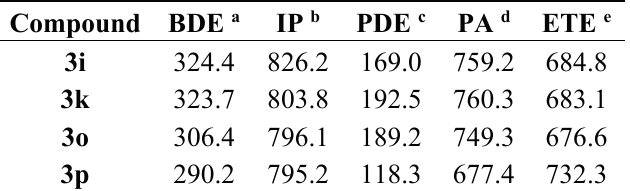
Table 2. IEF-PCM B3LYP/6-311++G** computed enthalpies (kJ·mol − 1 ) of reaction mechanisms